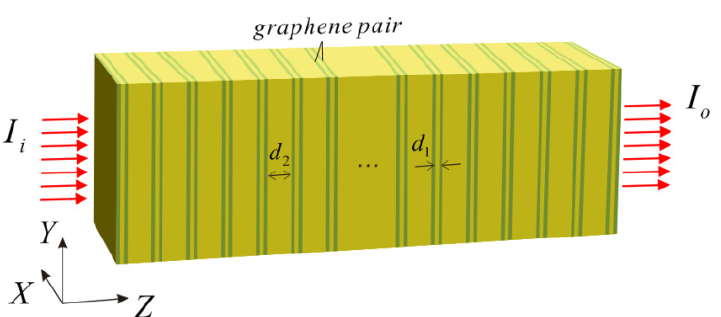
Figure 1. Schematic of graphene-pair arrays. The synthesized arrays are constructed by graphene sheets and dielectrics. The spatial period of graphene pairs is given by d = d 1 + d 2 . Graphene is an ultrathin two-dimensional nanomaterial and is generally treated as an equivalent dielectric with a considerable thickness of d g . This equivalent method for graphene is reasonable under the condition of d g < 1 nm, which has been verified by numerous experimental and simulating results